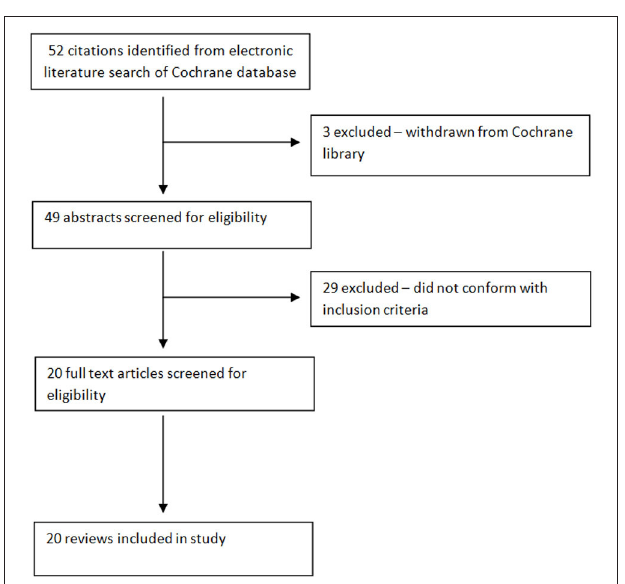
FIGURE 1 | Study flow